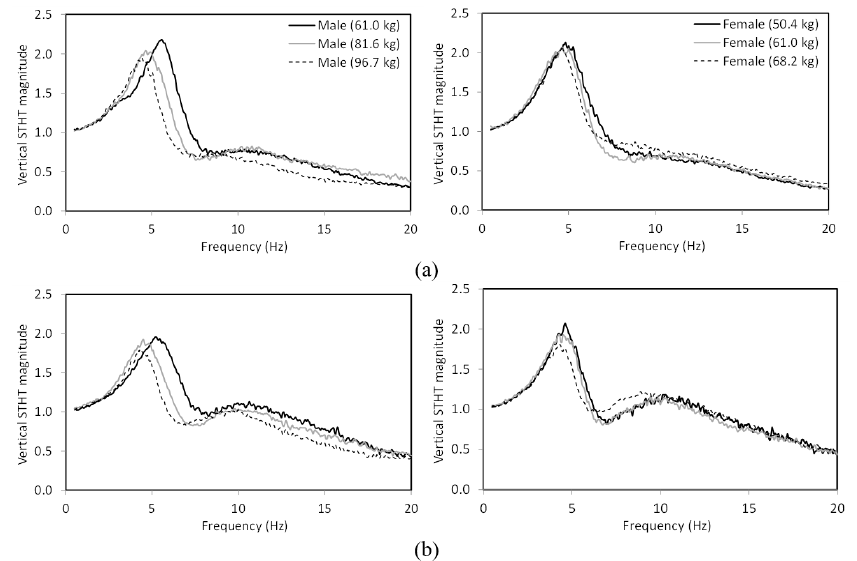
Figure 7. Mean vertical STHT magnitude responses of males and females within three different mass groups ( a ) without back support; and ( b ) with back support (excitation: 0.50 m/s 2 ).